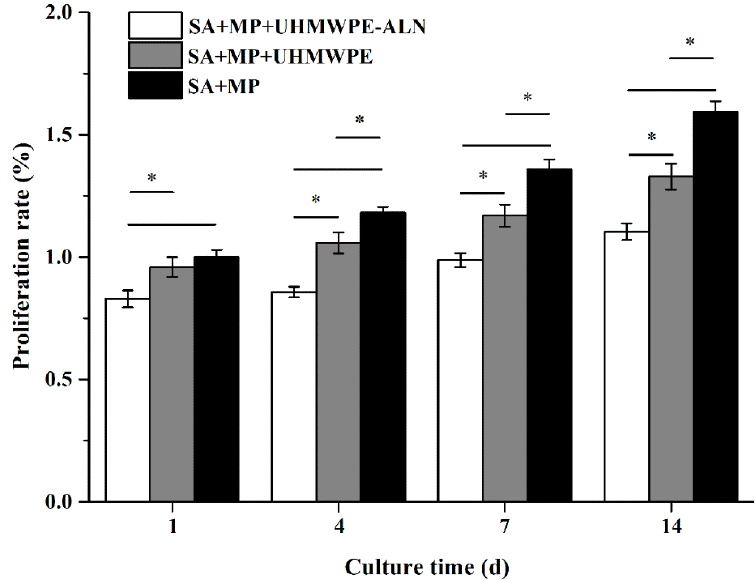
Figure 1. The relative proliferation rates of macrophages after being co-cultured with critical-sized UHMWPE-ALN wear particles in cell reactors for 1, 4, 7, and 14 d ( n = 3, * p < 0.05).